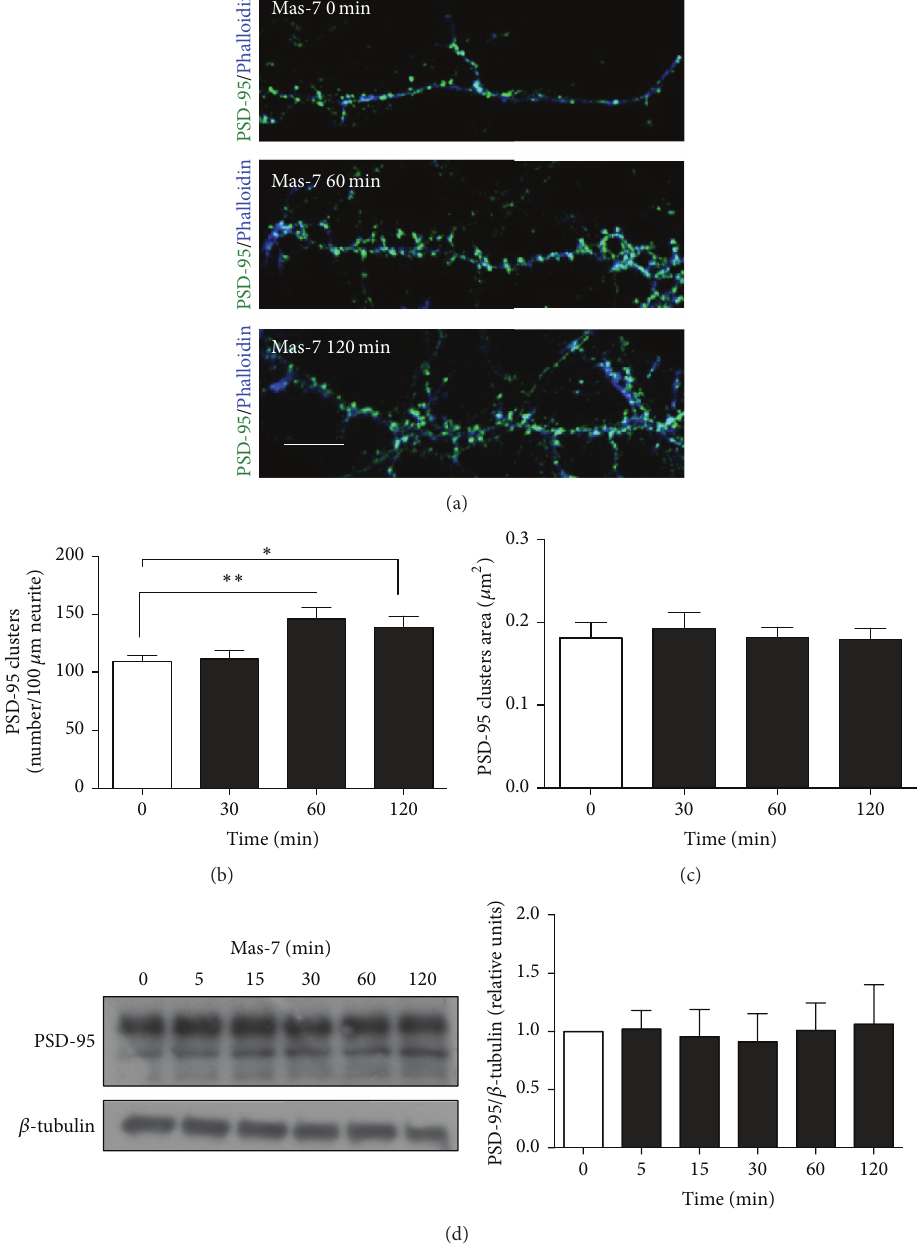
Figure 3: Mas-7 increases the number of PSD-95 clusters in hippocampal neurons. (a) Representative immunofluorescence images for PSD- 95 (green) and Phalloidin (blue) in hippocampal neurons exposed to Mas-7 for 0, 60, and 120min. Scale bar = 6 𝜇 m. (b) Quantification of number of PSD-95 clusters/100 𝜇 m of neurite ( 𝑛 = 4 ). (c) Quantification of PSD-95 cluster area ( 𝑛 = 4 ). (d) Western blot and quantification of total levels of PSD-95 in hippocampal neurons exposed to Mas-7 for different lengths of time ( 𝑛 = 3 ). ∗∗ 𝑝 < 0.01 and ∗ 𝑝 < 0.05